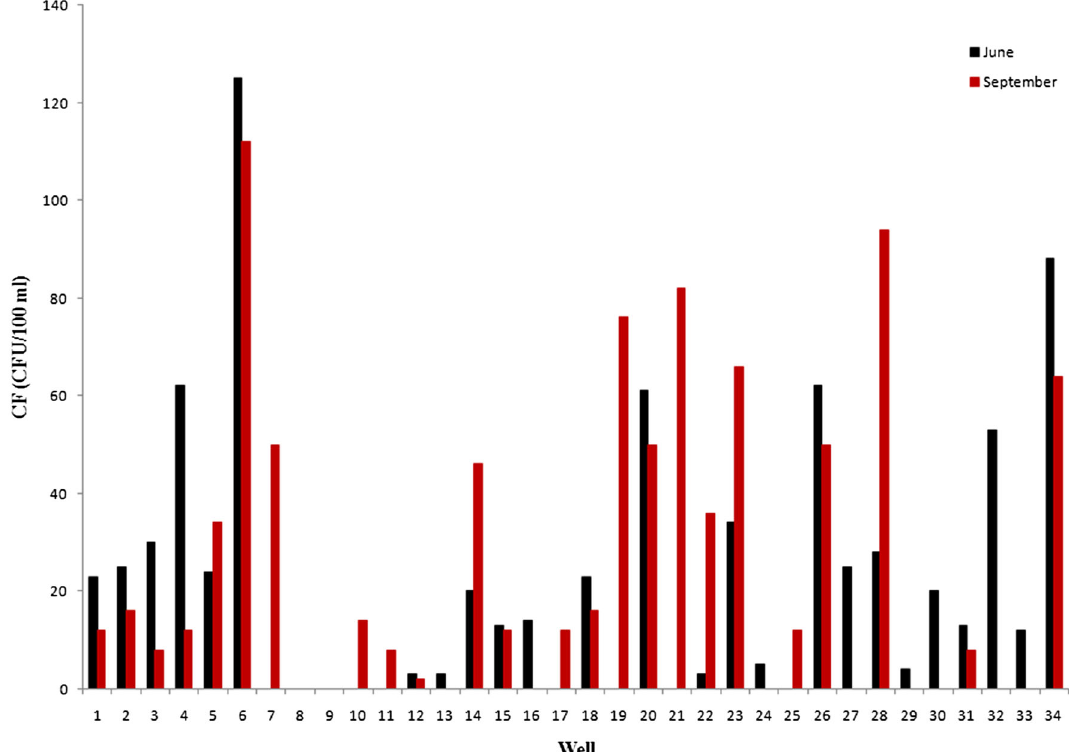
Fig. 3 Abundance of FC in groundwater ( vertical axis ) as sampled in June and November 2013 ( horizontal axis